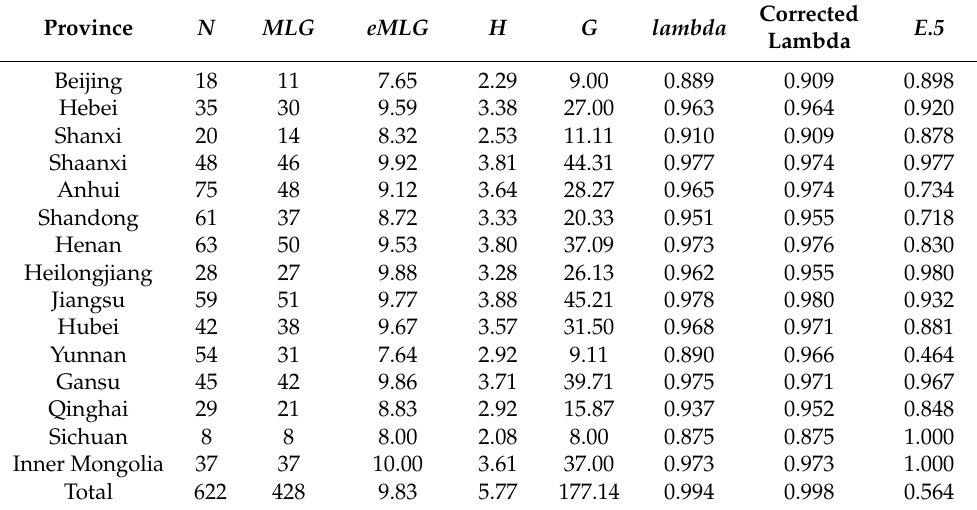
Table 3. Genotype diversity information of different Pt